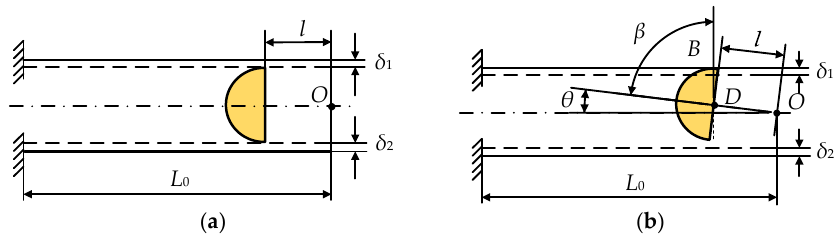
Figure 12. Schematic diagram of installation clearances of the variable stiffness actuator. ( a ) The initial state. ( b ) The critical position of the roller contacting with the leaf spring on one side.